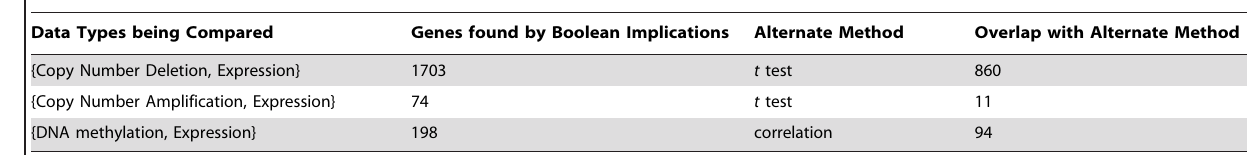
Table 7. Comparison between genes with cis -regulatory relationships found by Boolean implications and alternate